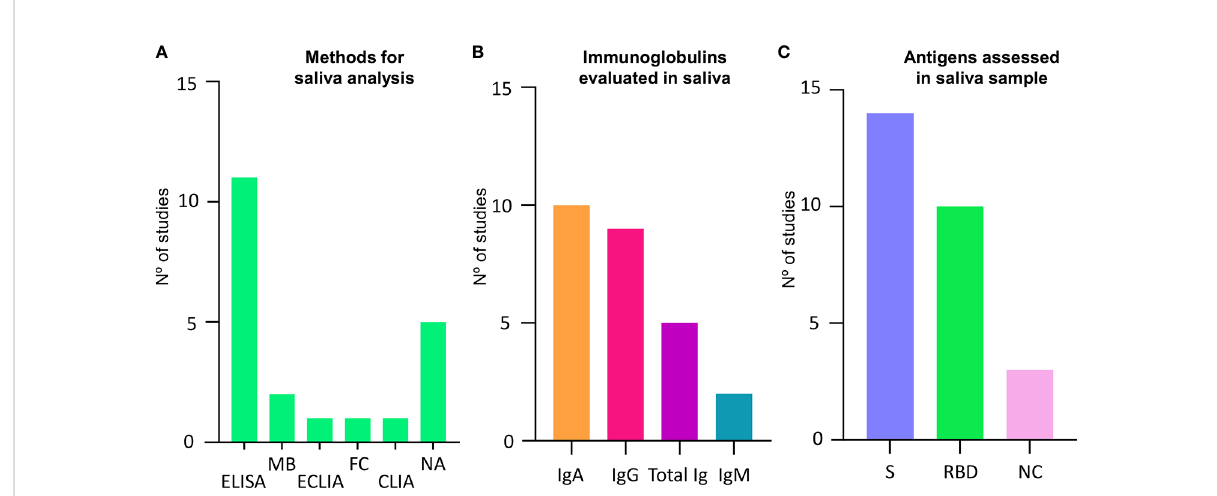
FIGURE 2 Characteristics of studies and antigen analysis in salivary samples. (A) Graphic showing the methods assessed and assays applied for saliva analysis and the number of studies using each type. (B) Graphic showing different immunoglobulins assessed and the number of studies assessing each type. (C) Graphic showing different antigen assessed for binding reaction and the number of studies assessing each type. CLIA, chemiluminescence immunoassay; ECLIA, electro-chemiluminescence immunoassay; ELISA, Enzyme-linked immunosorbent assay; FC,